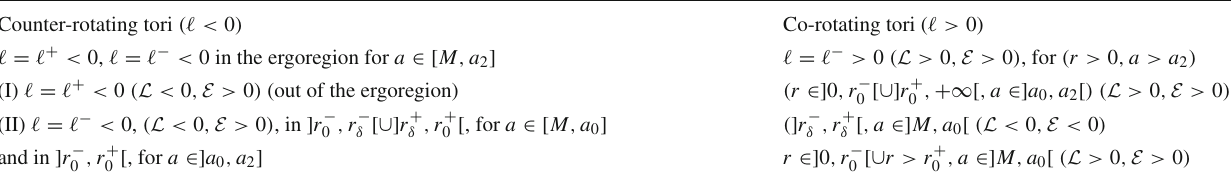
Table 3 Co-rotating and counter-rotating tori in Kerr NSs , (cid:6) is the fluid specific angular momentum. Radii r ± see also Fig. 1, spins are defined in Table 1. E and L are the test particles energy – and angular momentum